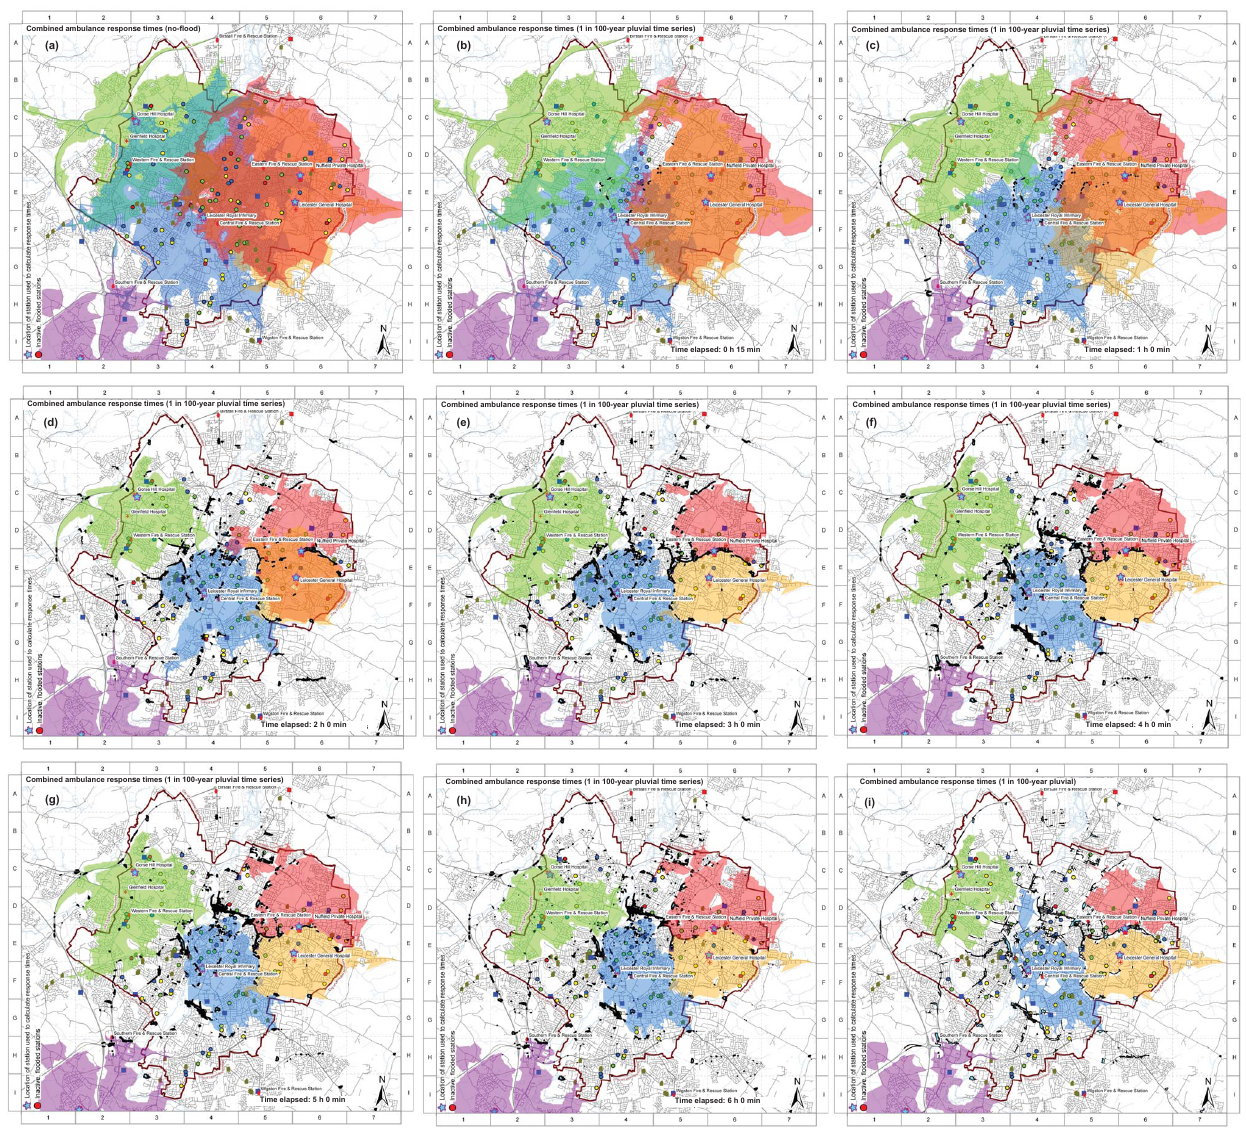
Figure 14. Combined ambulance service response zones during a 1 in 100-year surface water flood event. (a) No-flood conditions prior to the flood event, (b) 0.25h, (c) 1.0h, (d) 2.0h, (e) 3.0h, (f) 4.0h, (g) 5.0h, (h) 6.0h, at the end of the rainfall event and (i) static maximum flood depths recorded during the event. Refer to key in Fig. 7. Please see the Supplement for an animated version of Fig.